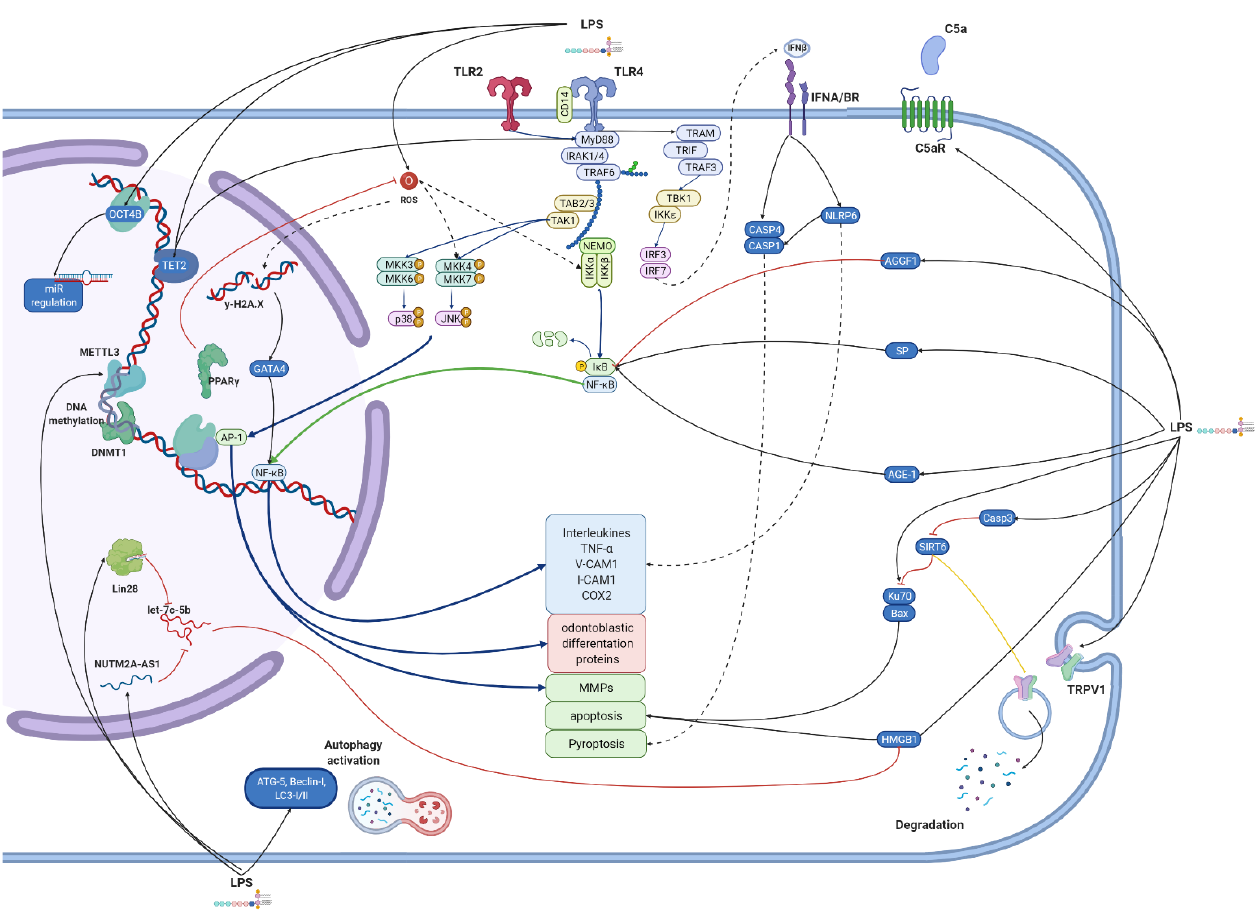
Figure 3. Molecular effects exerted by lipopolysaccharides on human dental pulp cells (hDPCs). Figure summarizes results from studies conducted on hDPCs, regardless of LPS origin. The main pathway activated by LPS involves TLR2/4 receptor. Groups of proteins transducing signal are colored differently. TLR pathway, via NF- κ B and MAPK, promotes release of interleukins (mainly IL- 1 β , IL-6 and IL-8), adhesive molecules (I-CAM, V-CAM), metalloproteases (MMPs) and odontoblastic differentiation proteins. This pathway is marked with thick blue arrows. LPS increases ROS activity in cells, changes microRNA profile, leads to apoptosis or pyroptosis. A variety of different pathways and particles activated in LPS-treated cells are presented both in deep blue brackets and by protein images with their names. Black arrows represent positive stimulation, dashed arrows show indirect activation, red ones—inhibition, yellow—ubiquitination, green—translocation to another cell compartment. Created with BioRender.com 7 December